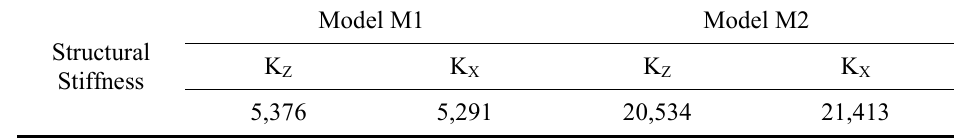
Effective global stiffness obtained for each FEM M1 and M2 - Units in